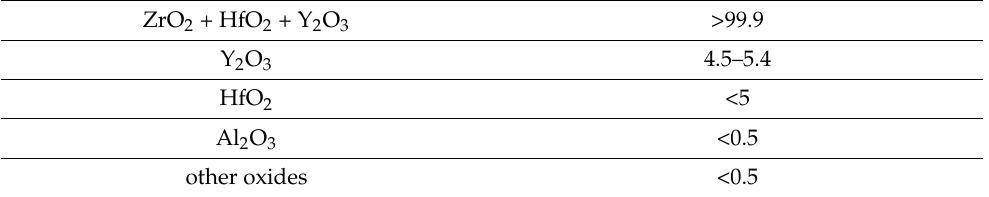
Table 1. Composition of the tested material (according to the manufacturer’s